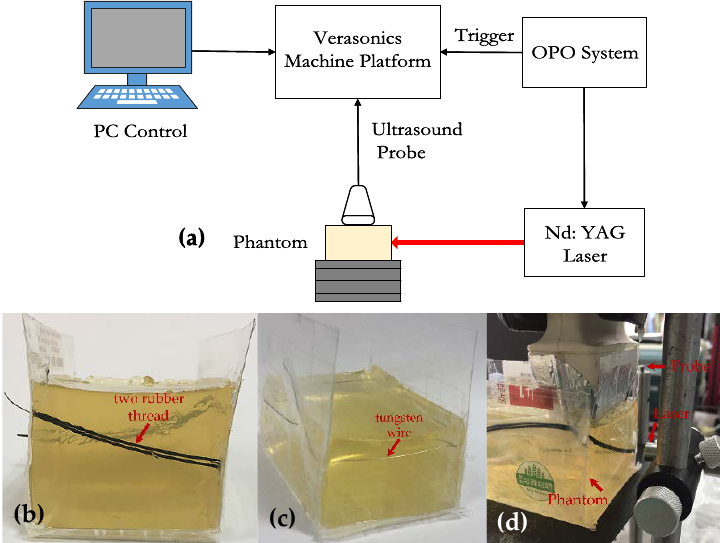
Figure 4. ( a ) Schematic of the experimental setup; ( b ) the phantom used as imaging target (two rubber threads); ( c ) the phantom to acquire the deconvolution kernel (one tungsten wire); ( d ) a photo of the experiment setup.